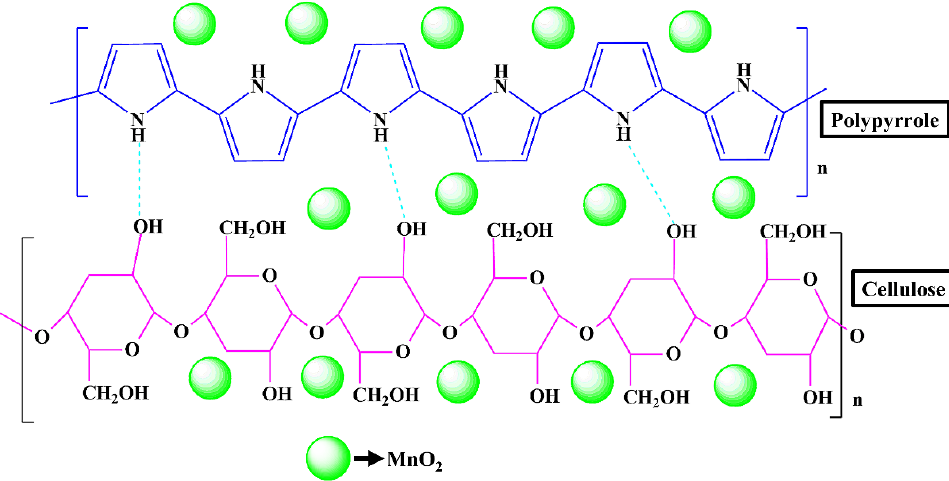
Figure 1. Chemical structure of MnO 2 @CE/PPy. The figure is not to scale.